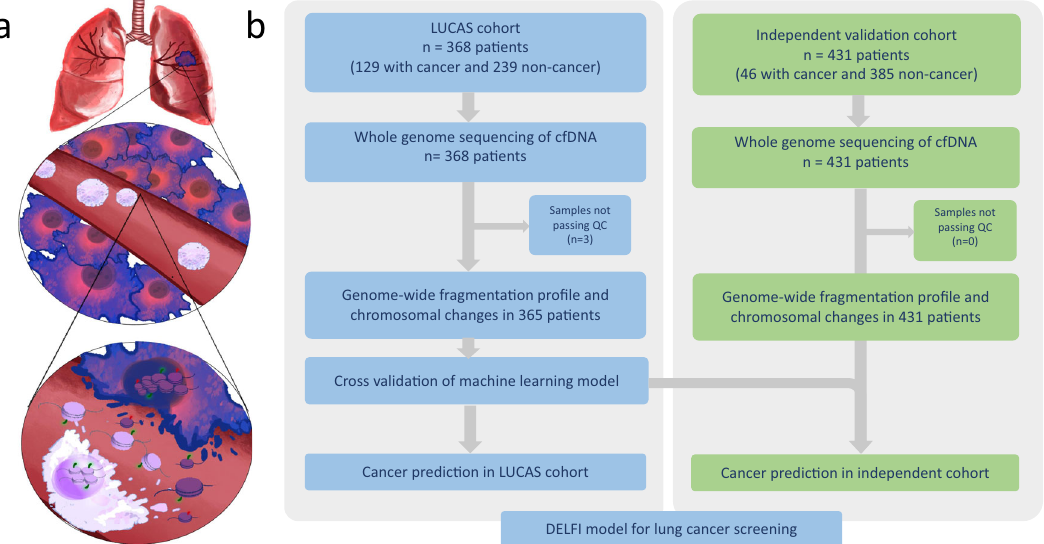
Fig. 1 Schematic of overall approach. a Schematic representation of DNA fragmentation and release from apoptotic lung cancer cells and WBCs. Nucleosomal DNA with variable length of linker DNA is preserved in the circulation with cancer cell cfDNA fragments having a more aberrant pro fi le compared to the cfDNA fragments arising from the WBCs. Mapping of the cfDNA fragments along the genome reveals distinct patterns in cancer patients compared to non-cancer individuals. b Outline of the DELFI approach for early detection of lung cancer. 365 patients from the LUCAS diagnostic cohort were analyzed to derive genome-wide fragmentation pro fi les that were used to train and evaluate the diagnostic performance in this cohort using a cross- validated machine learning model. A fi xed model was used to validate the performance in an independent cohort of 46 lung cancer patients and 385 non- cancer individuals. QC, quality control. Table 1 Patient demographics and clinical information in LUCAS cohort.